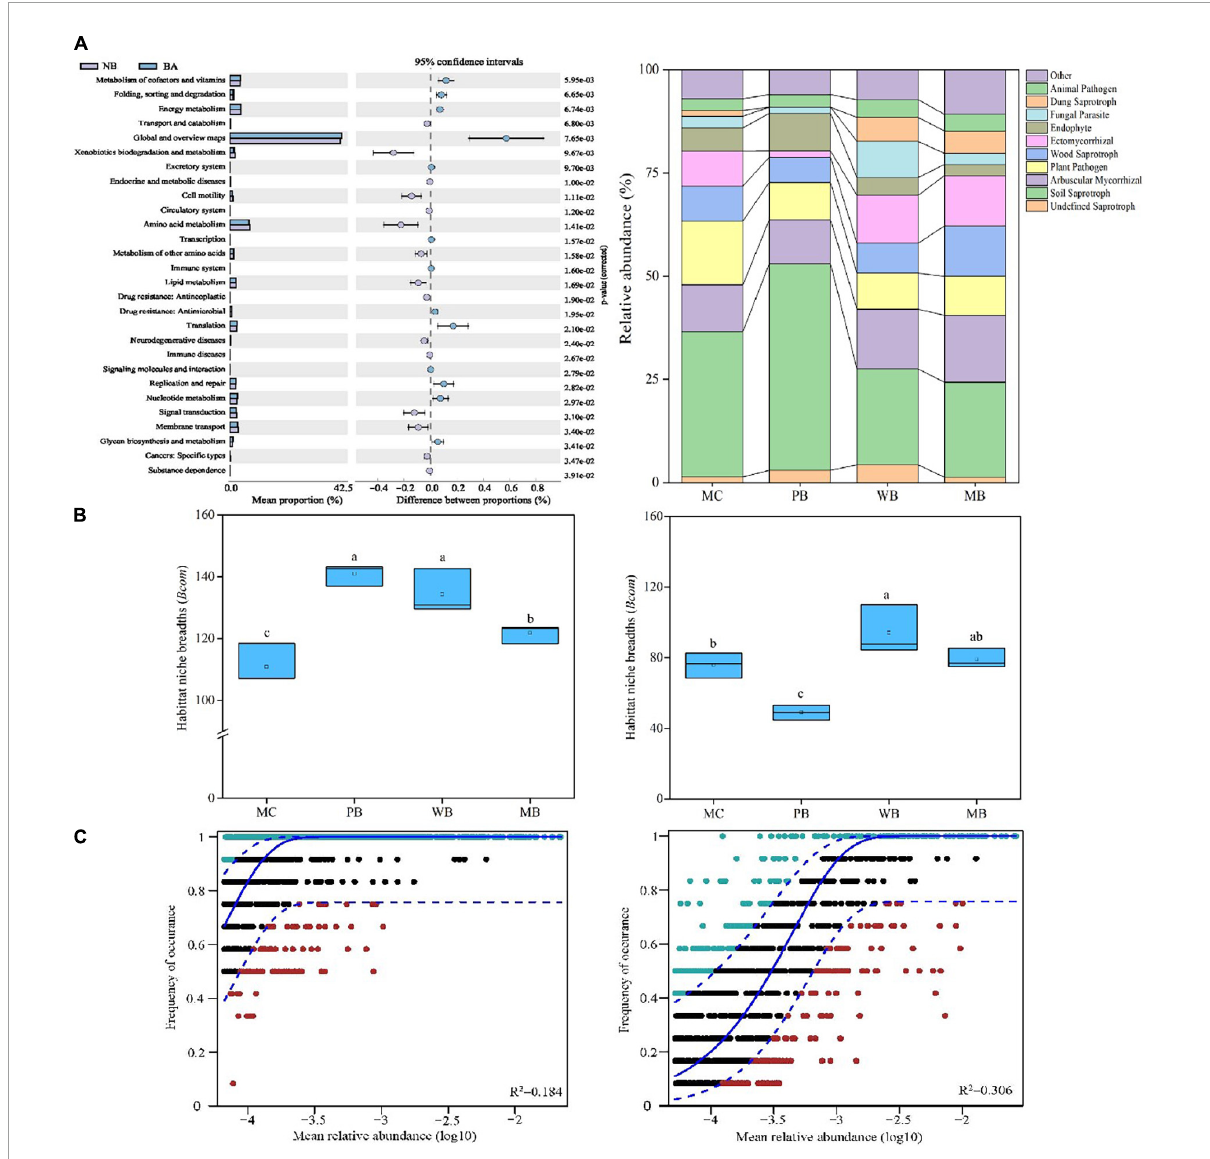
FIGURE7 Functional traits (A) , mean habitat niche breadth (B) , and fit of the Sloan neutral community model (C) of bacterial (left) and fungal (right) community of rhizosphere soil sampled on 3-year following amendment at 20 t ha − 1 . Functional traits of the bacterial community on KEGG pathway (KO tier 2) at DNA level of topsoil (0–15 cm) following amendment at 20 t ha − 1 with biochar (BA, average of WB and MB) relative to manure (no biochar, NB). (Left), a relative abundance of different functions of both fields; (Right), size of the proportion differences in the BA soils from the NB soil at 95% confidence interval, with the significance at p < 0.05. Fungal functions using FUNGuild with OTU data. For Sloan neutral community model, solid blue line represents the best fit to the Sloan neutral community model, and dashed blue line represents